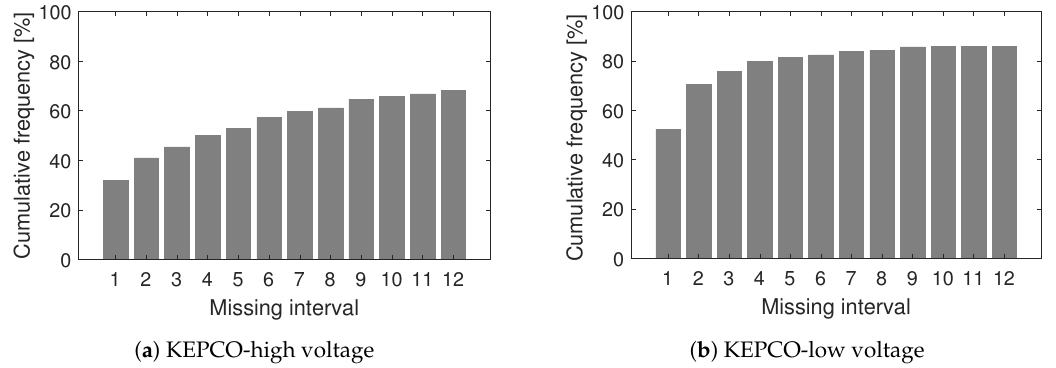
Figure 4. Histogram of cumulative frequency distribution of missing data.